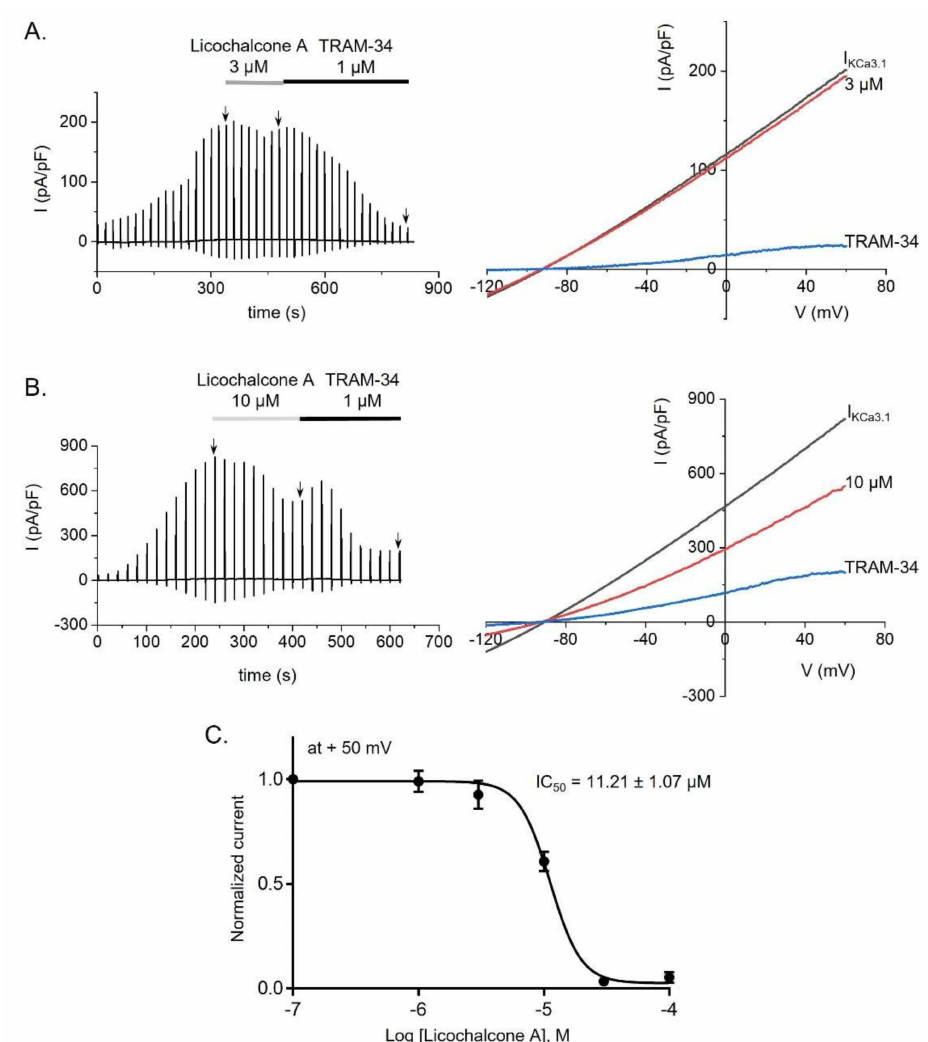
Figure 3. Licochalcone A inhibited KCa3.1 currents (I KCa3.1 ) in KCa3.1-overexpressing HEK293 cells. ( A ) A typical I KCa3.1 trace and I-V relationship demonstrates the effect of 3 µ M licochalcone A on I KCa3.1 in KCa3.1-overexpressing HEK293 cells following treatment with TRAM-34 (1 µ M), a selective blocking agent of the KCa3.1 channel. ( B ) A whole-cell trace and I-V relationships of I KCa3.1